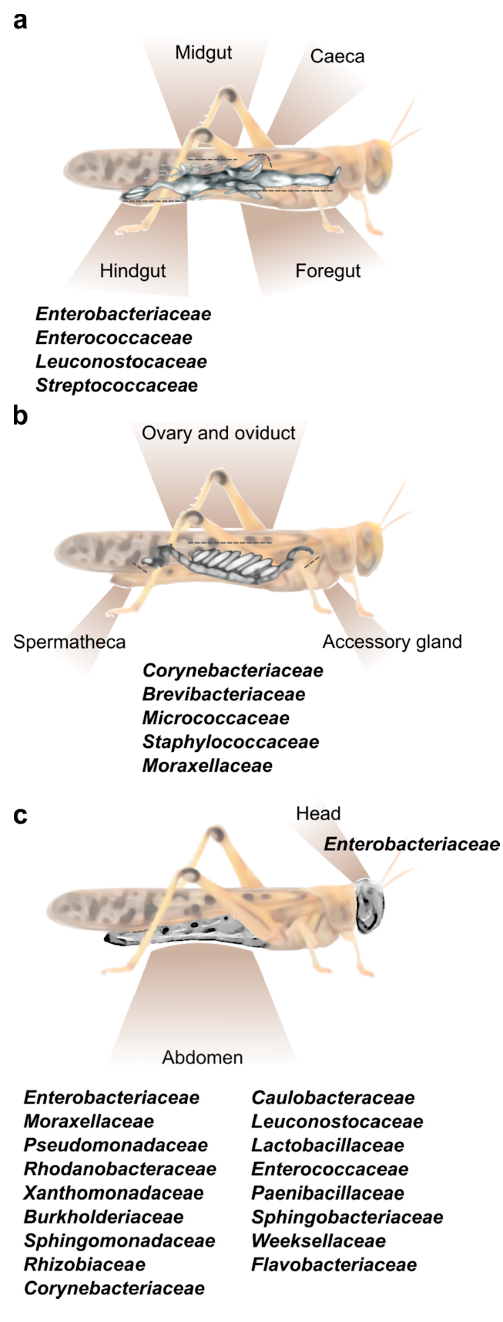
Figure 1. The main bacterial families known to inhabit different body parts of the desert locust. ( a ) A depiction of the locust’s alimentary canal and the common bacterial families residing within the hindgut. Foregut and hindgut (including caeca) do not host a constant fraction of specific bacterial strains [11,15]. ( b ) A depiction of the female locust reproductive system divided into three main sections, all harboring the same core bacterial families [16]. ( c ) External bacteria found on the head and abdomen cuticle of the desert locust [18,26].